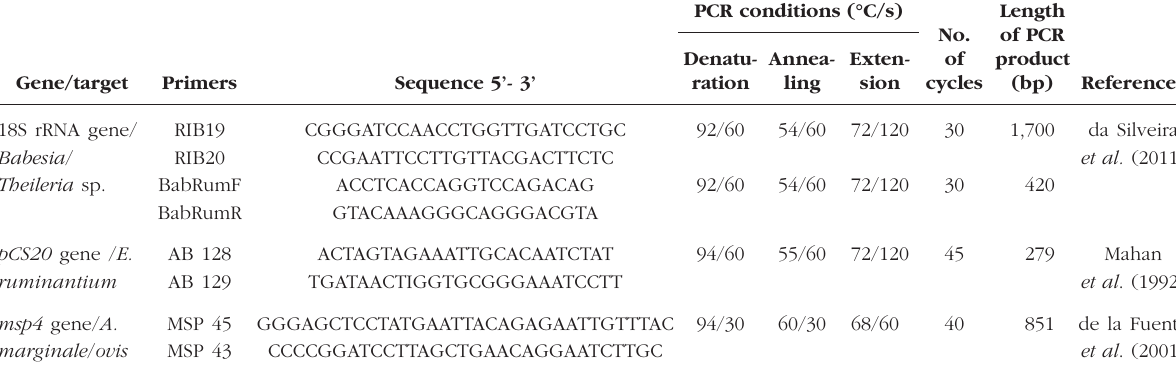
Table I. – PCR conditions and primers used in the study.